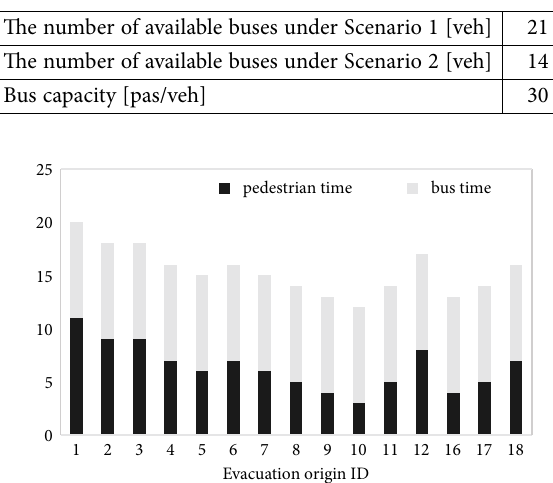
Figure 3. Evacuation during time for each evacuation origin under Scenario 1